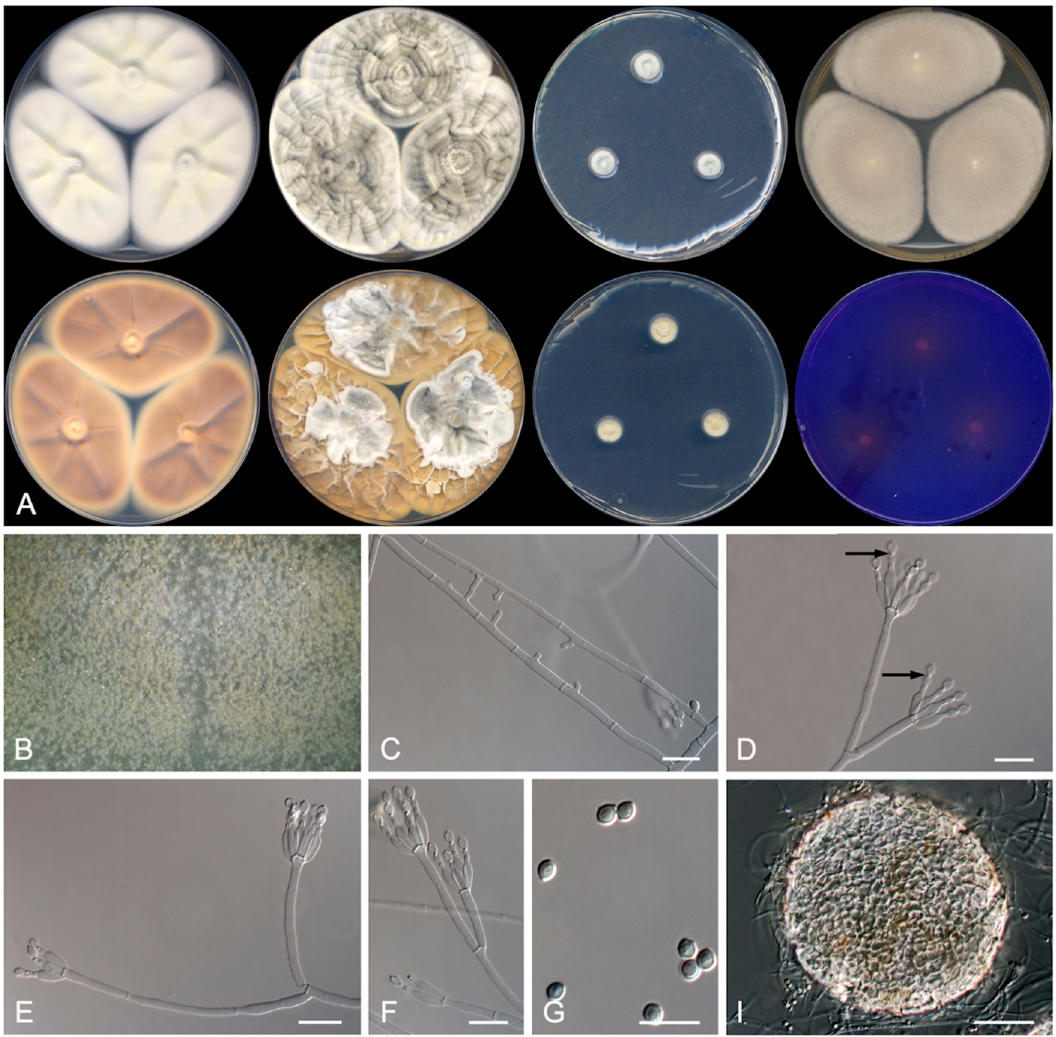
Figure 4. Morphological characters Penicillium michoacanense FMR 17,612 T . ( A ) Colonies after 14 days at 25 °C (top row, left to right: surface on CYA, YES, DG18, and MEA; bottom row, left to right: reverse on CYA, YES and DG18, and surface on CREA). ( B ) Detail of the colony on OA under the stereomicroscope. ( C ) Anastomosing hyphae. ( D – F ). Conidiophores (arrows showing disjunctors between conidia). ( G ) Conidia. I. Sclerotium. Scale Bar: ( C – G ) = 10 μ m; I = 50 μ m.